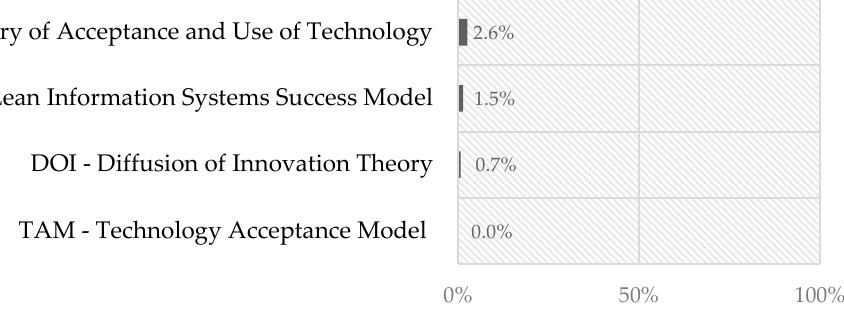
Figure 6. Awareness of IT adoption models/theories in projects (results compiled from the two surveys).